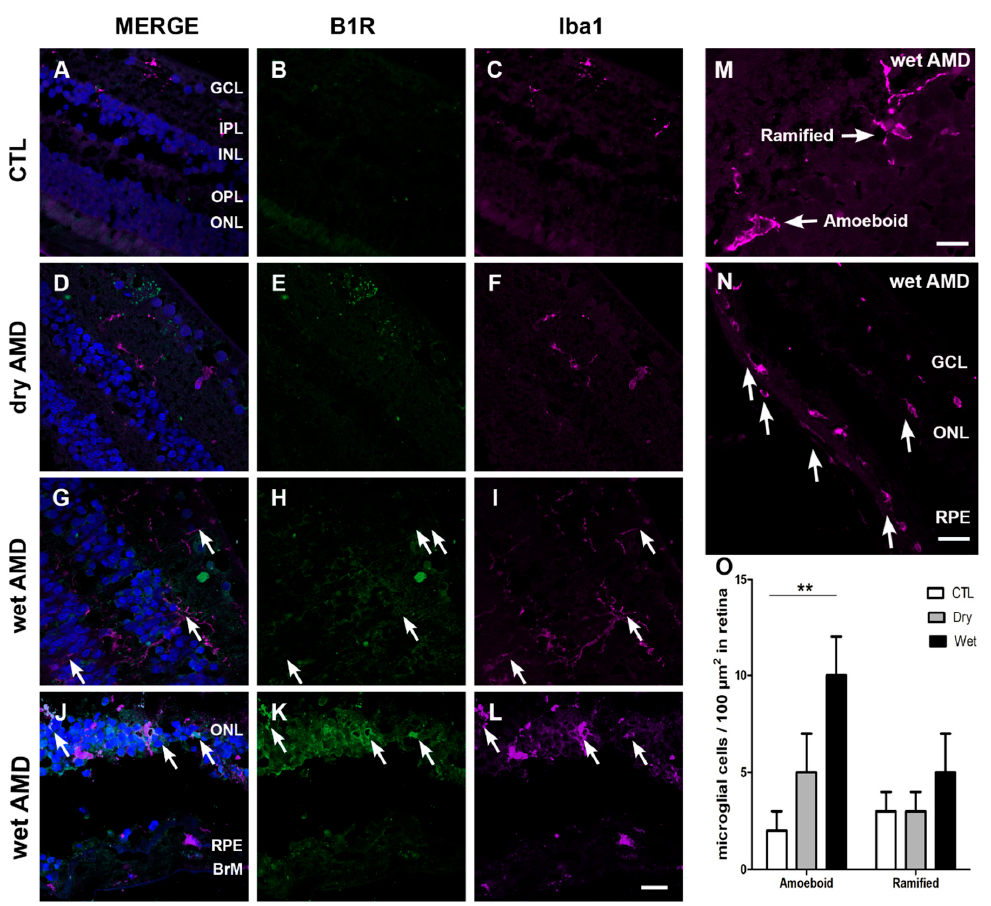
Figure 5. B1R colocalization with microglia in human retinae. ( A–L ) Microphotographs showing ionized calcium-binding adapter molecule 1 (Iba1) immunoreactivity and co-expression with B1R. Iba1 (purple) was markedly increased in all the layers of wet AMD retinae (arrows in I and L ), when compared to the control ( C ) and dry AMD ( F ) retinae. In both forms of AMD, microglia activation was observed (arrow in F , I and L ), indicated by hypertrophic somatic areas and highly activated microglia. Iba1 double immunostaining with B1R shows a co-expression of these two proteins all over the wet AMD retinae only ( G and J ). Sections are all counterstained for 4 ′ ,6-diamidino-2-phenylindole (DAPI; blue), which labels cell nuclei ( A , D , G , J ). (M) ramified and amoeboid shape microglia. ( N ) Infiltrating microglia in the RPE layer. Images are: A – L ; 40× (20 μ m), M ; 60× (10 μ m) N ; 20× (40 μ m). (O) Counting of ramified and amoeboid microglia in the retina. Data represent mean intensity ± SEM after subtraction of the background intensity. ∗∗ p < 0.005 wet AMD compared with the control (CTL). BrM: Bruch’s membrane, GCL: ganglion cell layer, IPL: inner plexiform layer, INL: inner nuclear layer, OPL: outer plexiform layer, ONL: outer nuclear layer, RPE: retinal pigment epithelium.